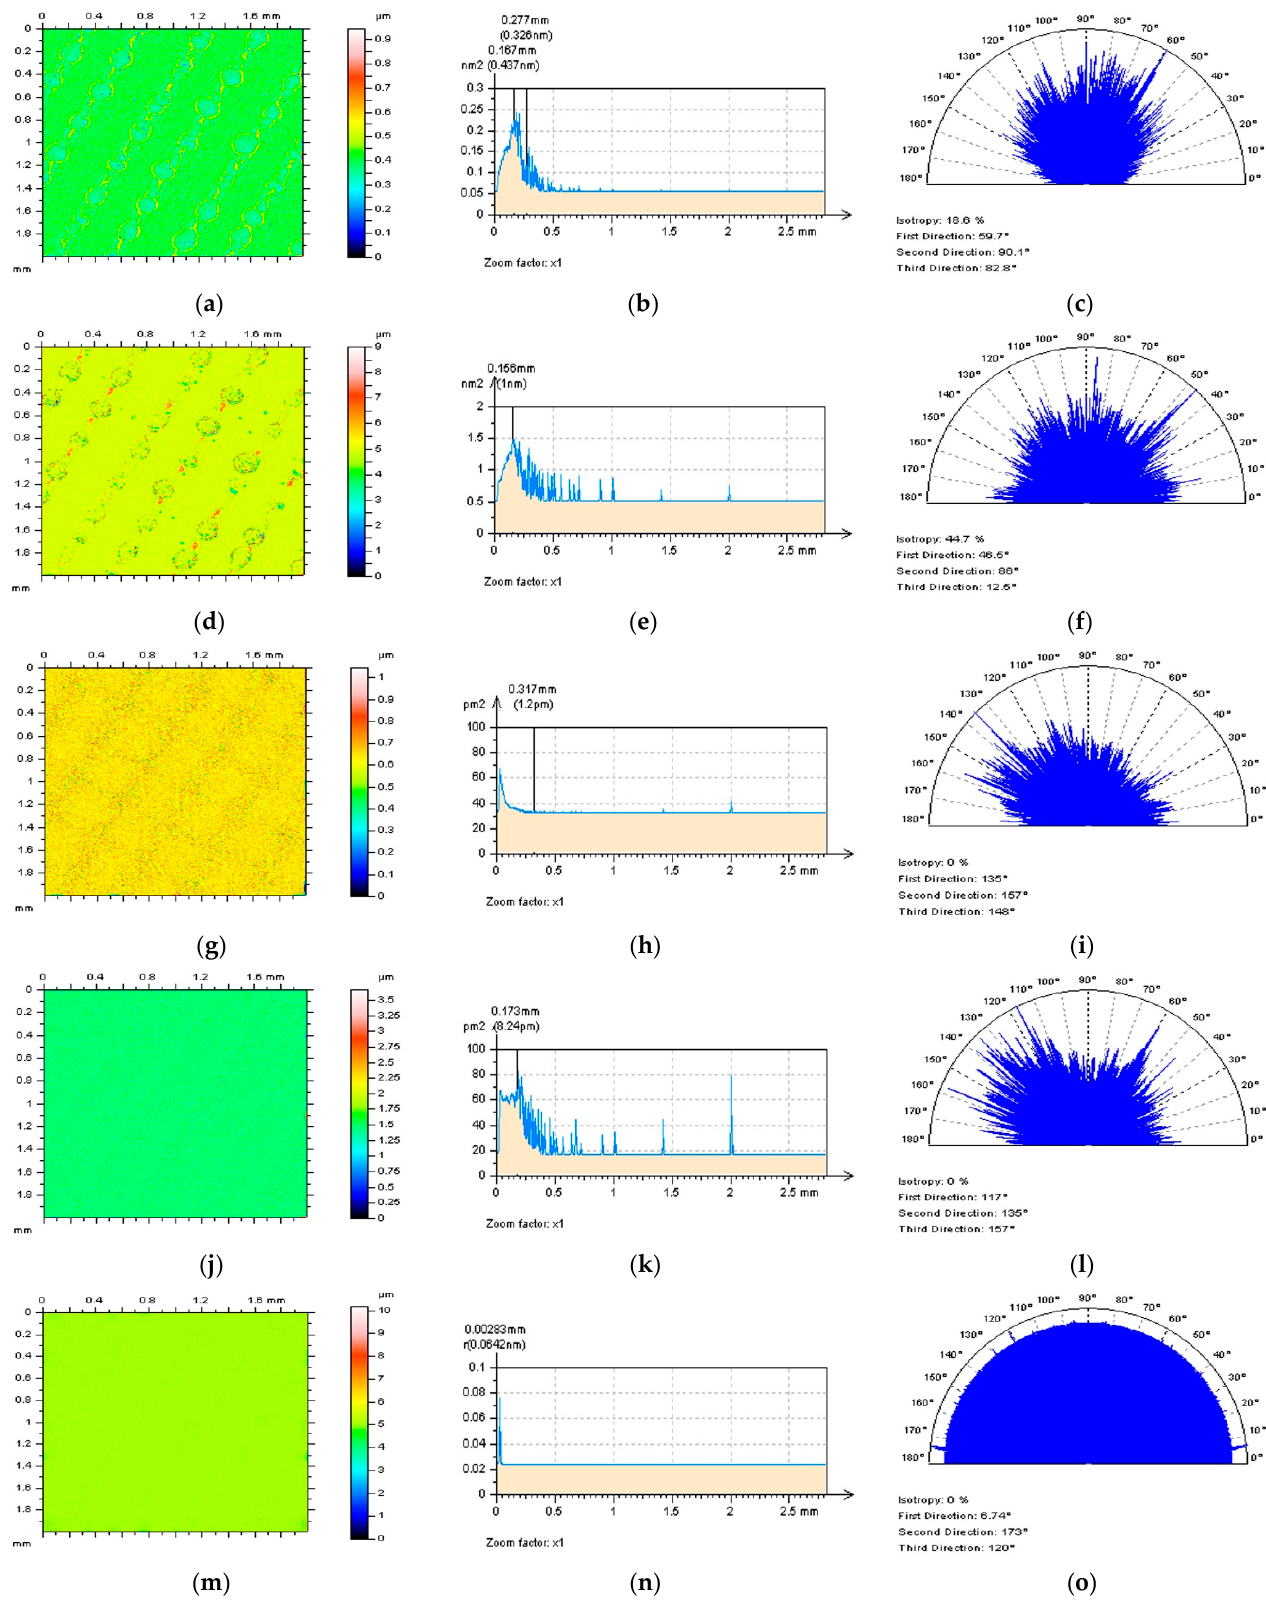
Figure 10. Analysis of a HFNS (left column), their PSDs (middle) and TDs (right column) received from a 30° right rotated laser ‐ textured surface by usage of the following filtering approaches: GF ( a – from a 30 ◦ right rotated laser-textured surface by usage of the following filtering approaches: c ), RGF ( d – f ), SF ( g – i ), MDF ( j – l ) and FFTF ( m – o ) approach, cut–off = 0.015 mm.